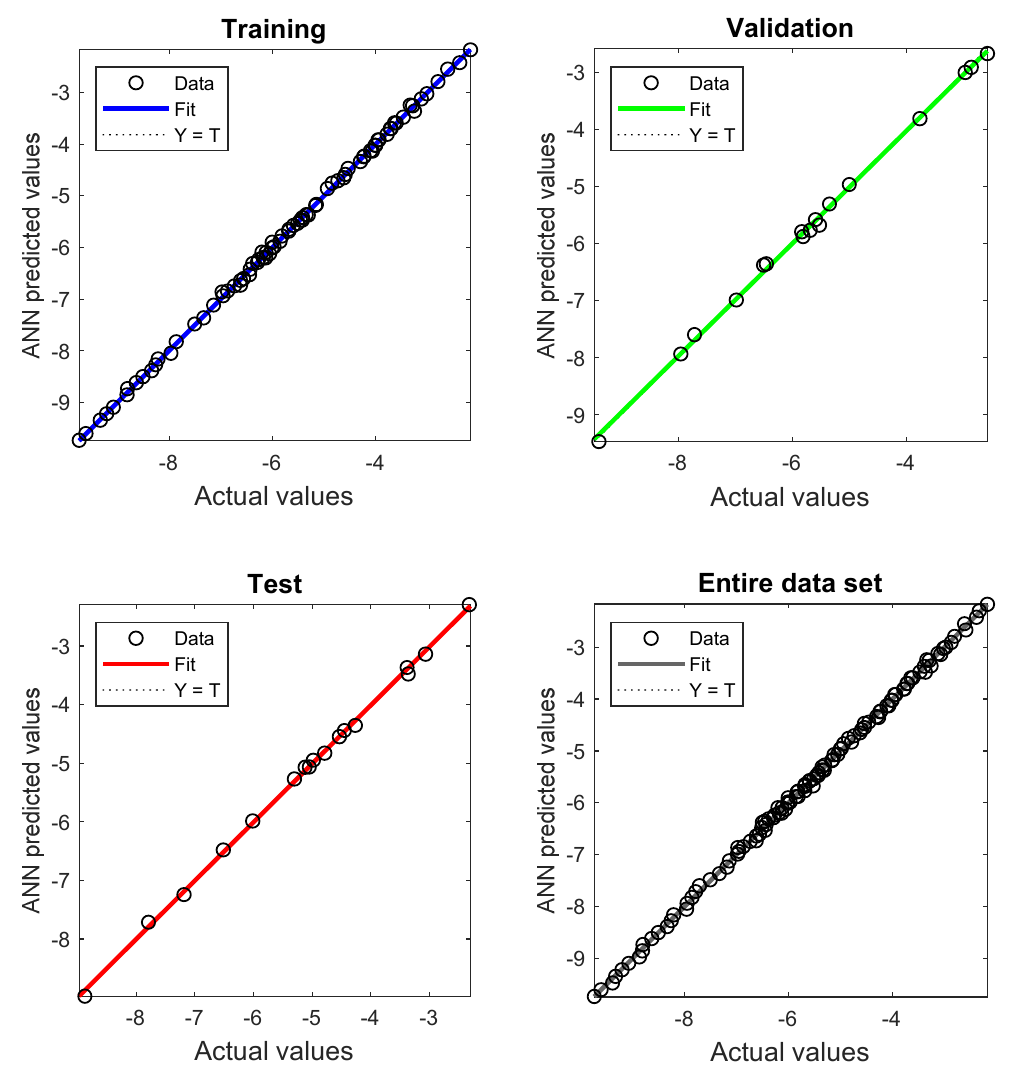
Figure 13. Training, validation and test regression plots. Table 3. The main parameters of the ANN